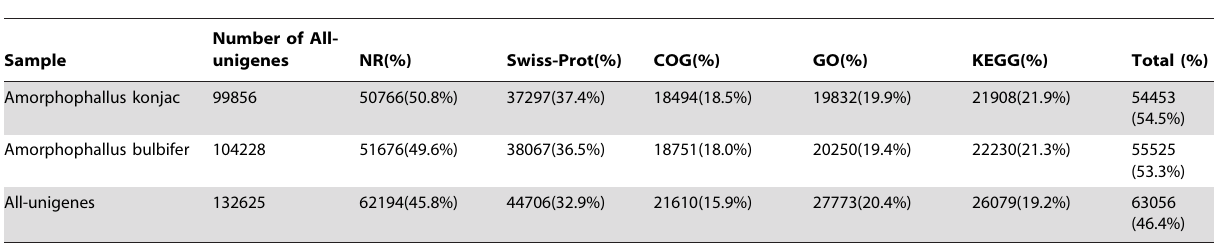
Table 2. BLAST analysis results against important public databases.